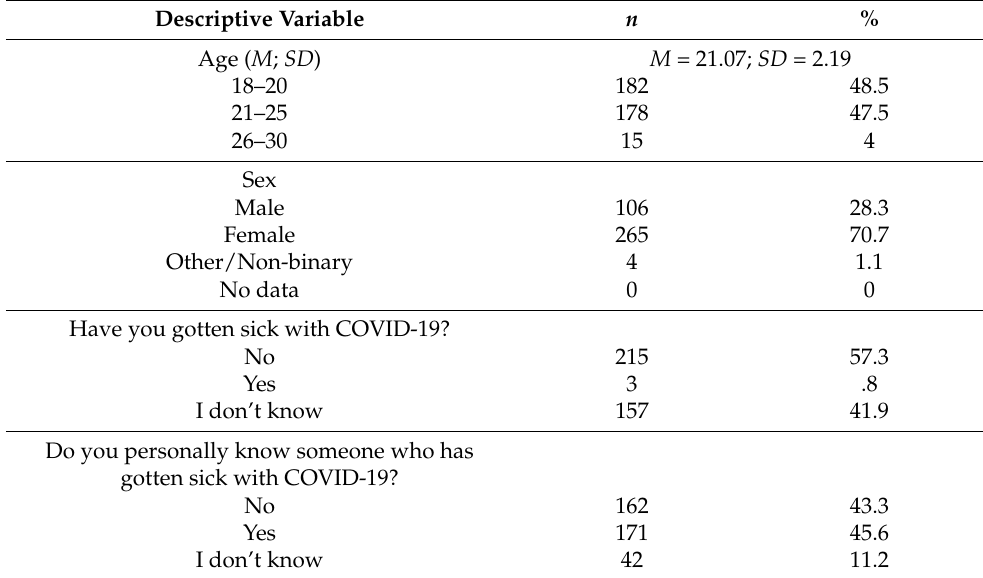
Table 5. Participants’ demographic data (Study 2). Descriptive